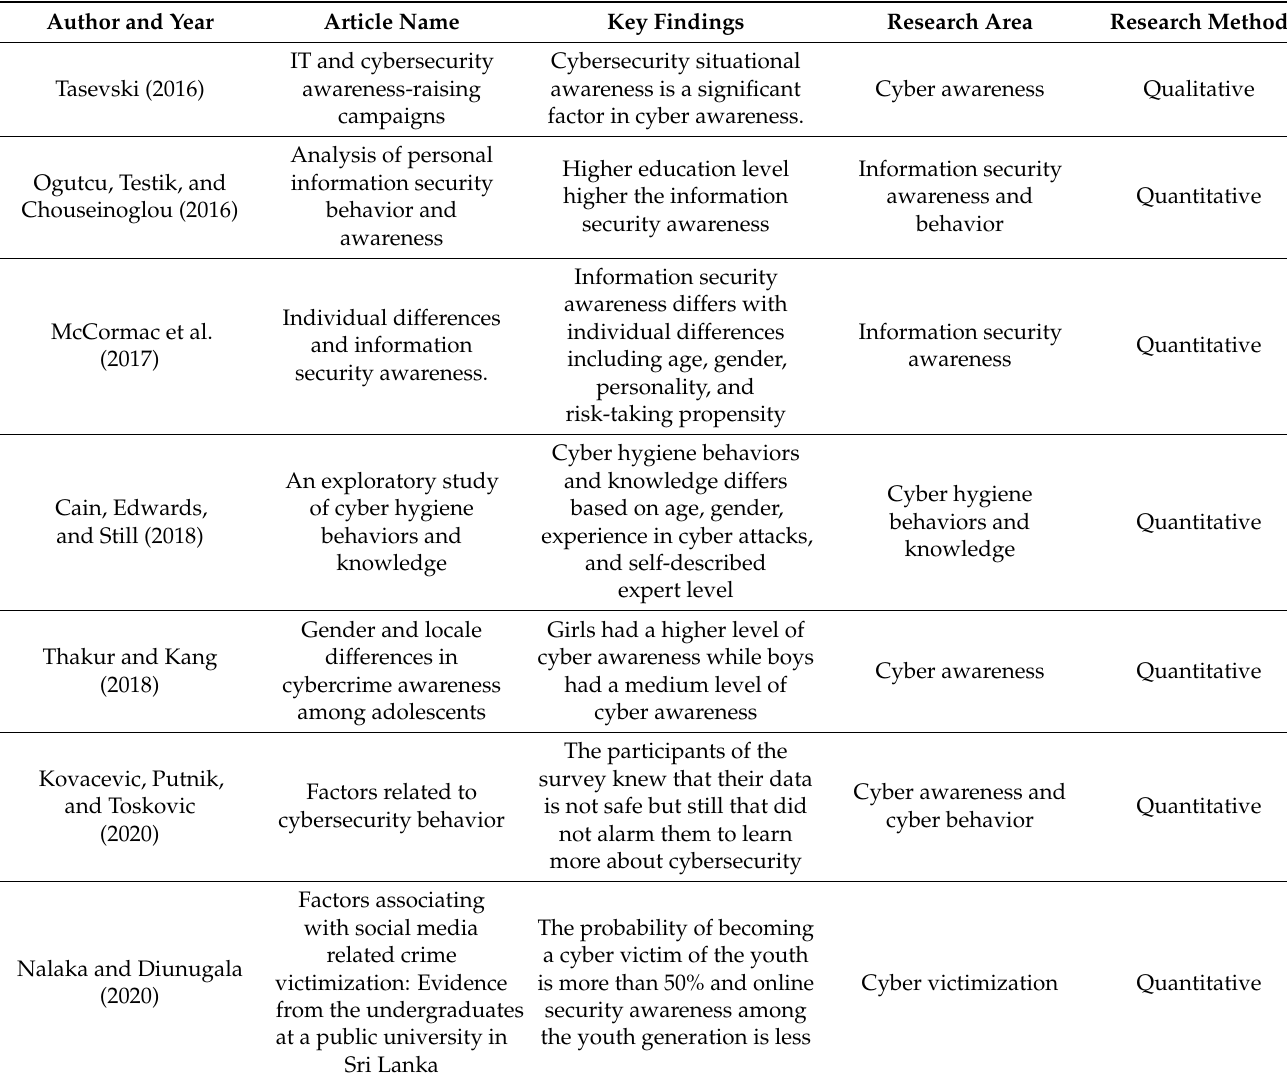
Table A4. User awareness when using the internet.